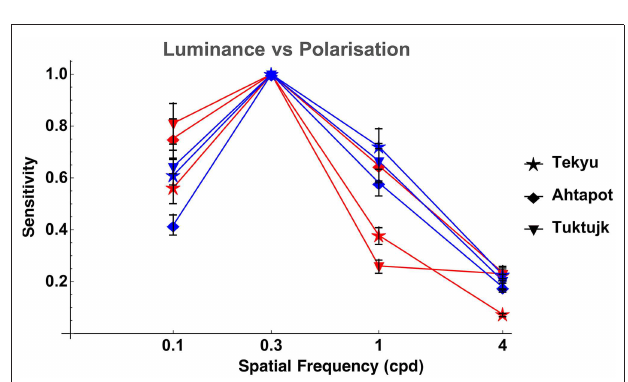
FIGURE 5 | Comparison of LCSF (blue) and PCSF (red) of three octopuses (normalized to the peak sensitivity value of each curve at 0.3 cpd). The error bars indicate bootstrap interquartile range. It can be appreciated that the shapes of the sensitivity curves are quite similar, although the differences between them are inconsistent: polarization sensitivity is higher than luminance sensitivity for two octopuses (Ahtapot and Tuktujk) at low spatial frequency (0.1 cpd), and lower than luminance sensitivity at a higher spatial frequency (1 cpd) for two out of three octopuses (Tekyu and Tuktujk).